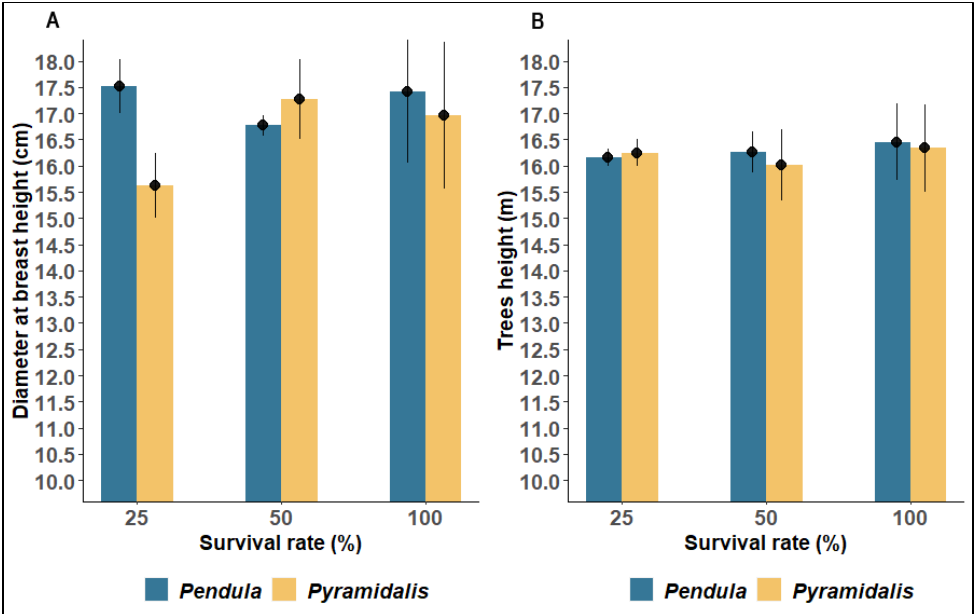
Figure 4. Variation in the growth traits: diameter at breast height ( A ) and tree height ( B ) by survival rate. The black vertical lines represent the standard deviation.